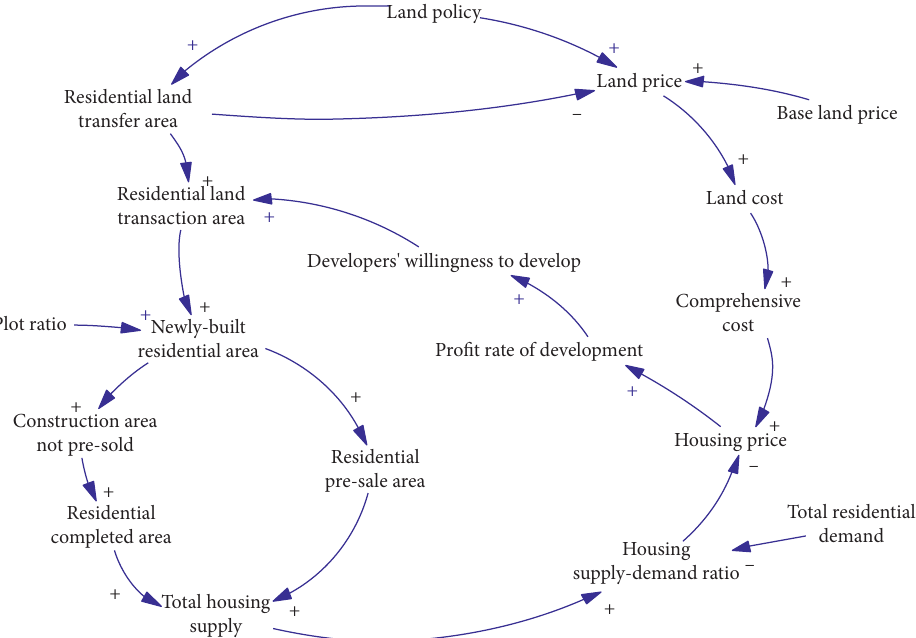
Figure 6: Causality diagram of residential land subsystem.